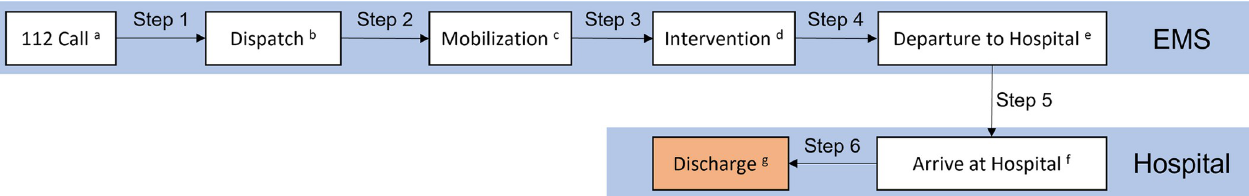
Fig 1. Flowchart of the time periods analysed. a Call is picked up by the 112 operator. b A message with the mission data is sent to the ambulance. c Ambulance starts moving towards the mission address. d Ambulance stops upon arrival at the mission address. e Ambulance with the patient begins to move towards the hospital. f Ambulance with the patient stops upon arrival at the hospital. g Patient is discharged from the hospital (to home or another health centre).